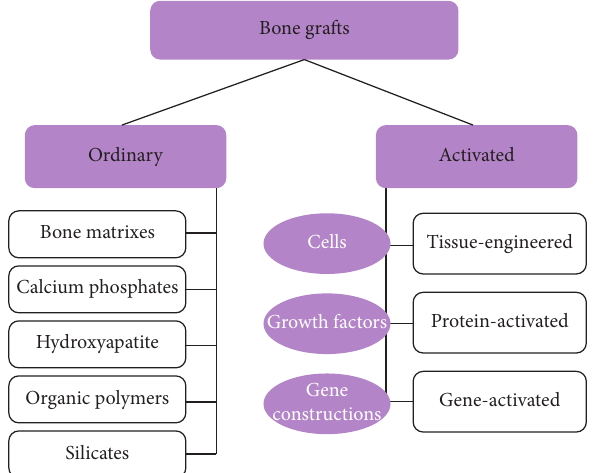
Figure 3: Types of ordinary or activated bone grafts